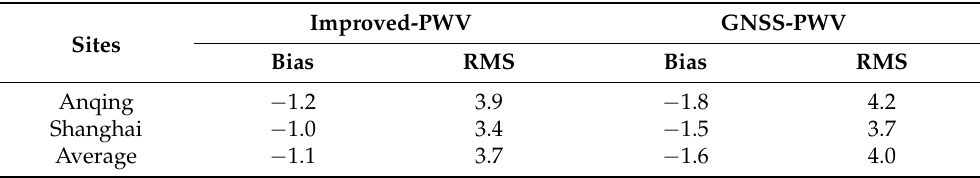
Table 6. Precision of the GNSS-PWV and the improved-PWV at the co-located GNSS and radiosonde stations in Anqing and Shanghai during the 2016–2019 period (mm). Improved-PWV GNSS-PWV Sites Bias RMS Bias RMS Anqing − 1.2 3.9 − 1.8 4.2 Shanghai − 1.0 3.4 − 1.5 3.7 Average − 1.1 3.7 − 1.6